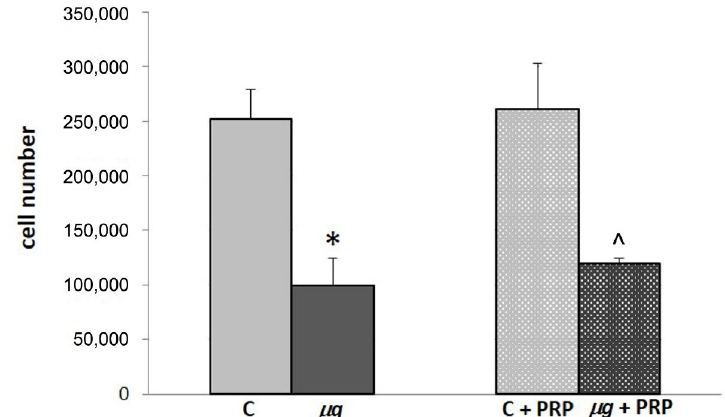
Figure 8. Effect of PRP treatment on NIH-3T3 cells exposed to modeled μg : cell count. Cells were PRP (1:1000). At the end of exposure, cells were collected and counted with a Burker’s chamber. * p < 0.05 vs. C, ^ p < 0.05 vs. C + PRP, ( n =